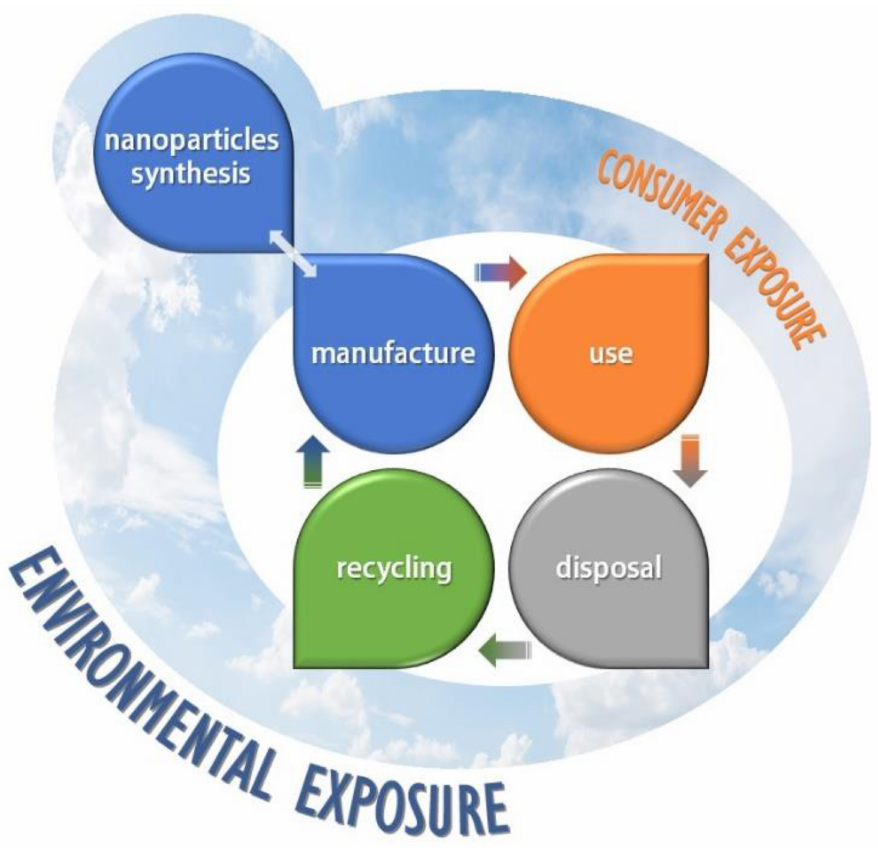
Figure 2. The life cycle of nanoparticle-containing